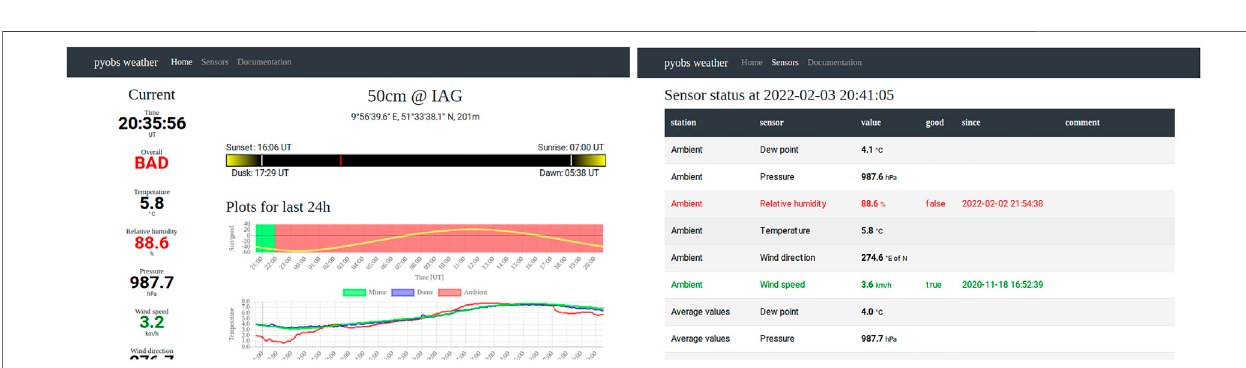
FIGURE 7 | Two screenshots from the pyobs-weather web frontend for the IAG 50 cm telescope. The main page is shown on the left and the Sensors page on the